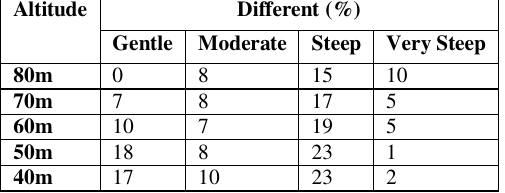
Table 5. Percentage of Slope Attributes For Different Altitude